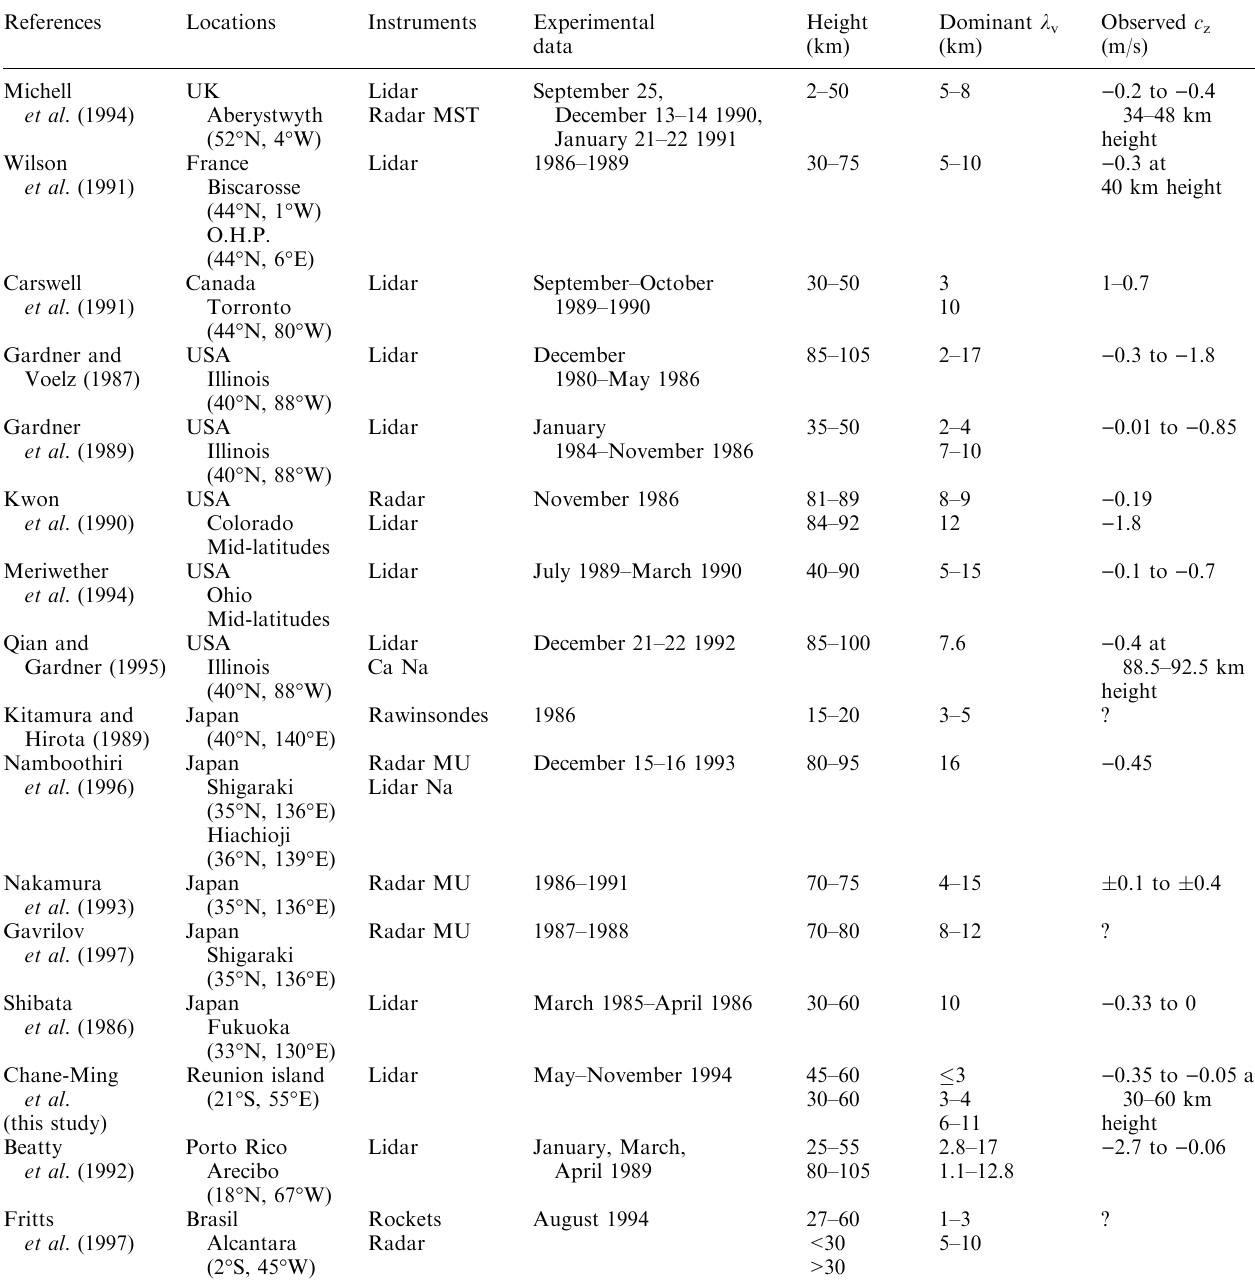
Table 2. A selection of results of gravity wave parameters in mid-latitude, tropical and equatorial